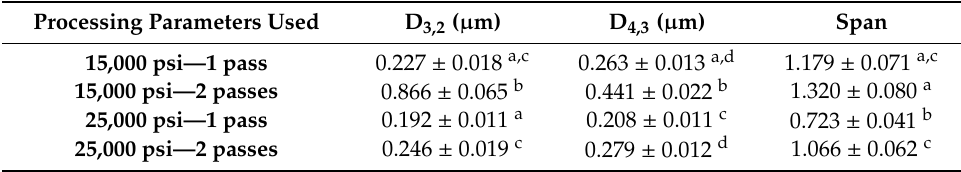
Figure 1. Droplet size distributions for a 50 / 50 system as a function of the processing parameters studied. Table 1. Sauter diameter ( D 3,2 ), volumetric diameter ( D 4,3 ), and span values for a 50 / 50 system as a function of processing parameters. a–c Mean value ± standard deviation; values without common superscripts within the same column were significantly different ( p < 0.05).